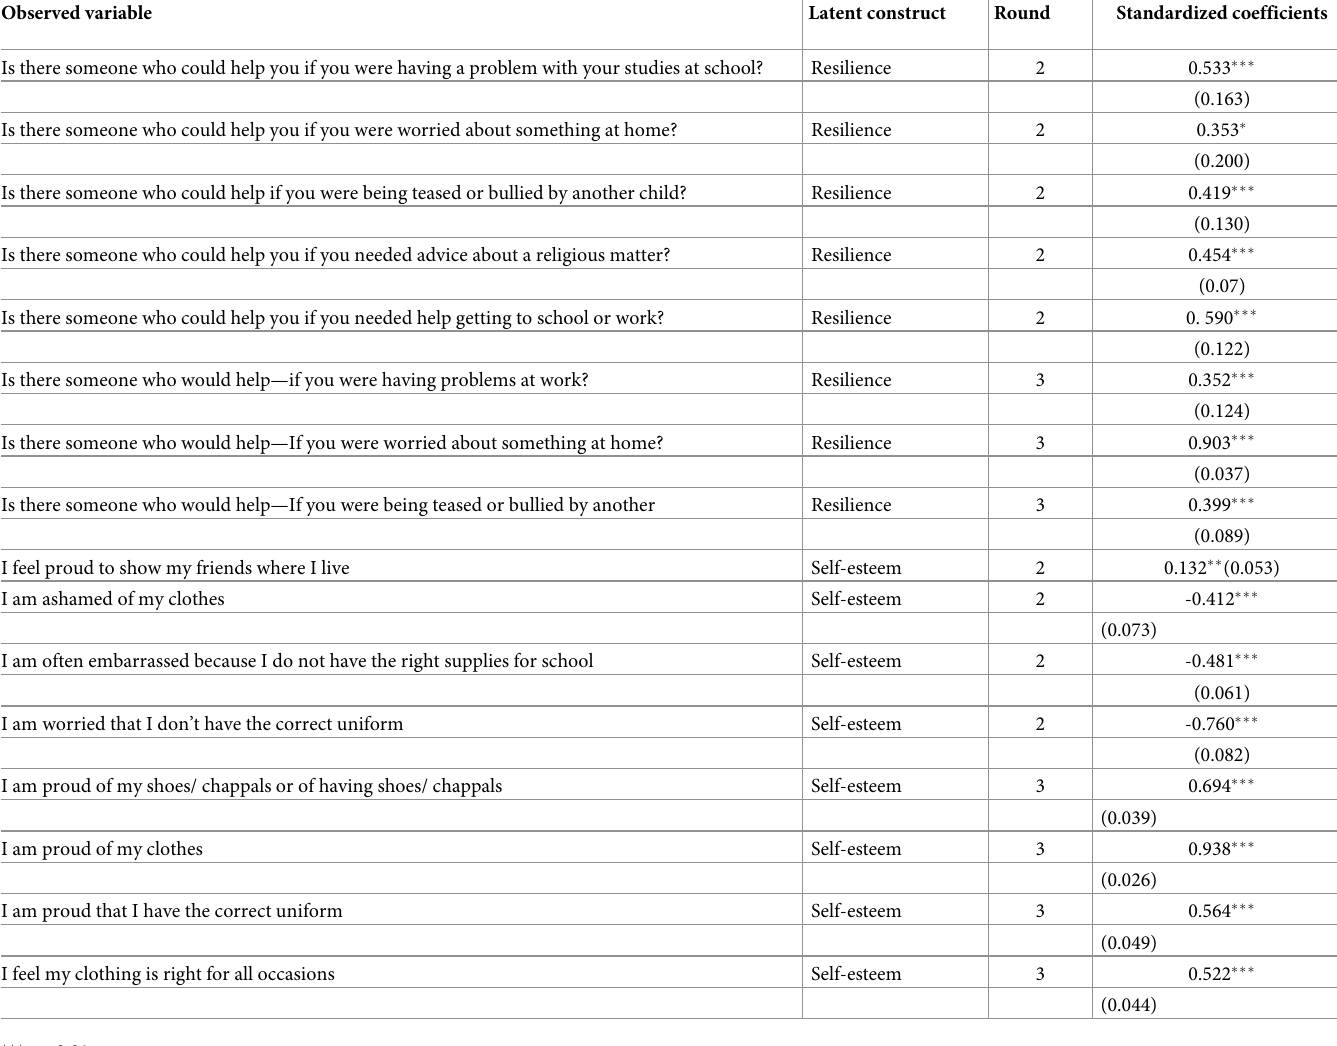
Table 1. Factor loadings for round two and round three non-cognitive skills latent constructs. Observed